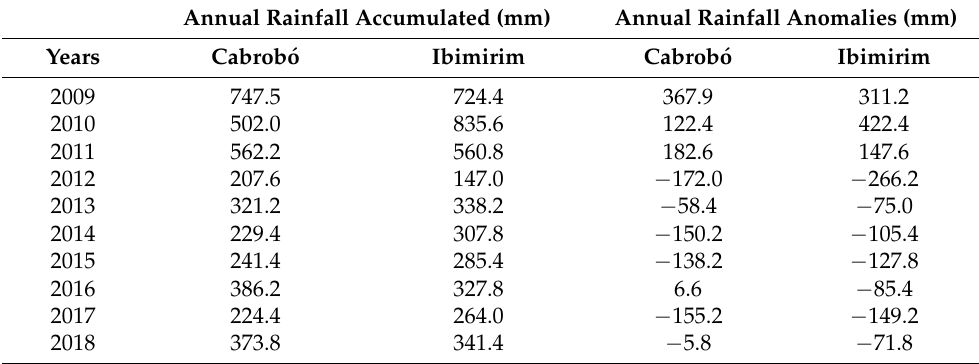
Table 3. Annual accumulated rainfall and annual anomalies to the period from 2008 to 2018 in Cabrob ó and Ibimirim. Annual Rainfall Accumulated (mm) Annual Rainfall Anomalies (mm) Years Cabrob ó